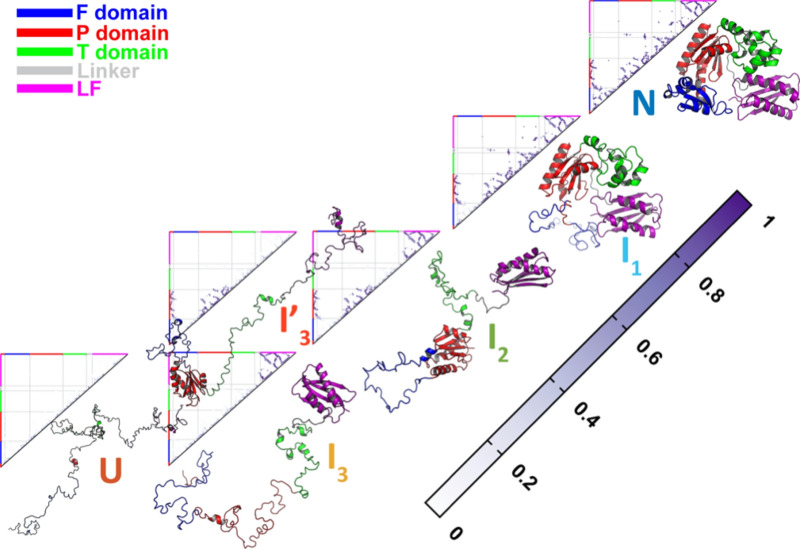
Native contact maps of DPO4 for the folding states U, I3, I3′, I2, I1, and N at the folding temperature Tfρ0.